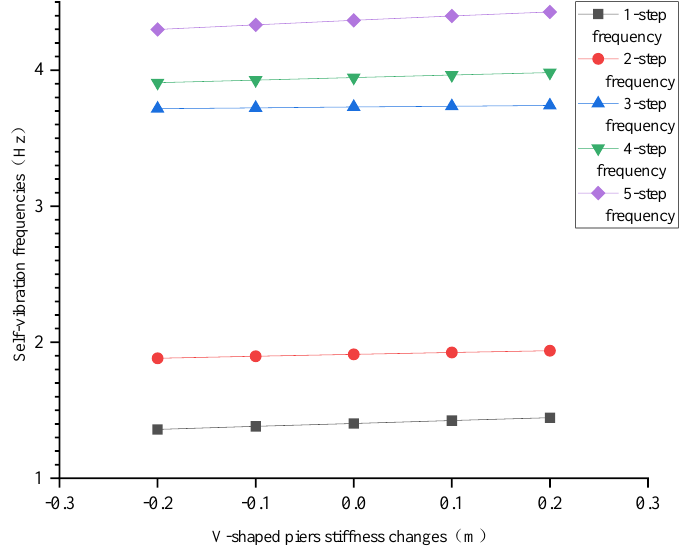
Figure 11. Self-vibration frequencies for different V-shaped pier stiffnesses of the original structure. The original structure has no change in the first ten orders of vibration after changing Table 8. Self-vibration frequencies (Hz) for different V-shaped pier stiffnesses of Structure I. Modal